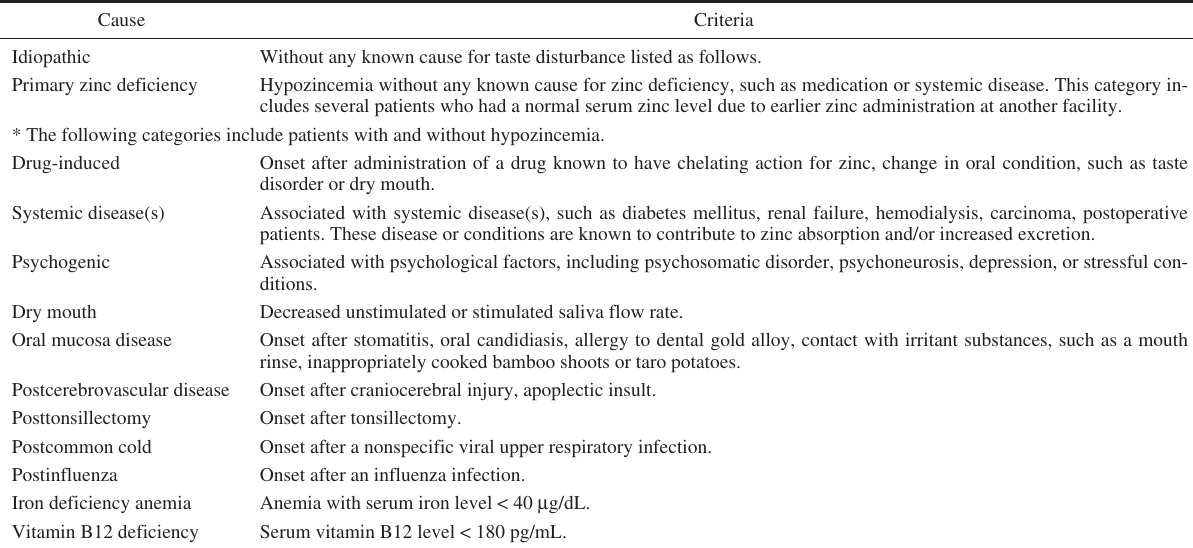
Table 2. Diagnostic criteria for the causes of taste disorders.